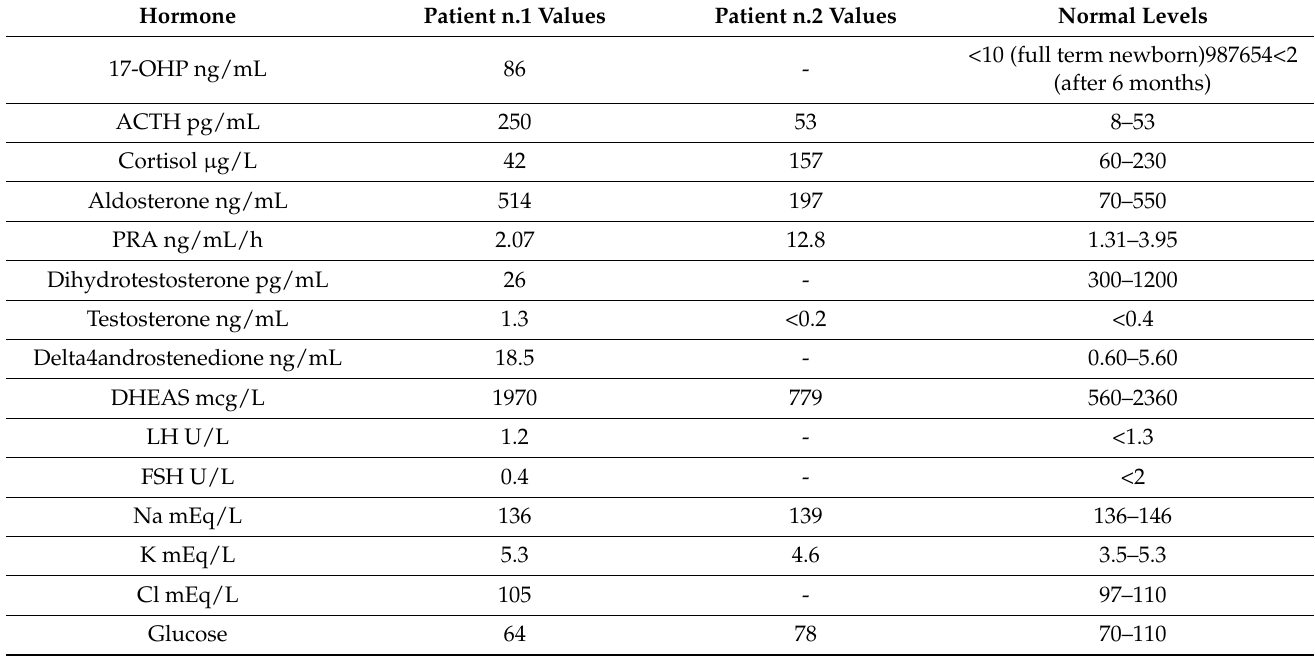
Table 1. Details regarding the hormonal tests of patient n.1 at the age of three days and patient n.2 at the age of two and a half